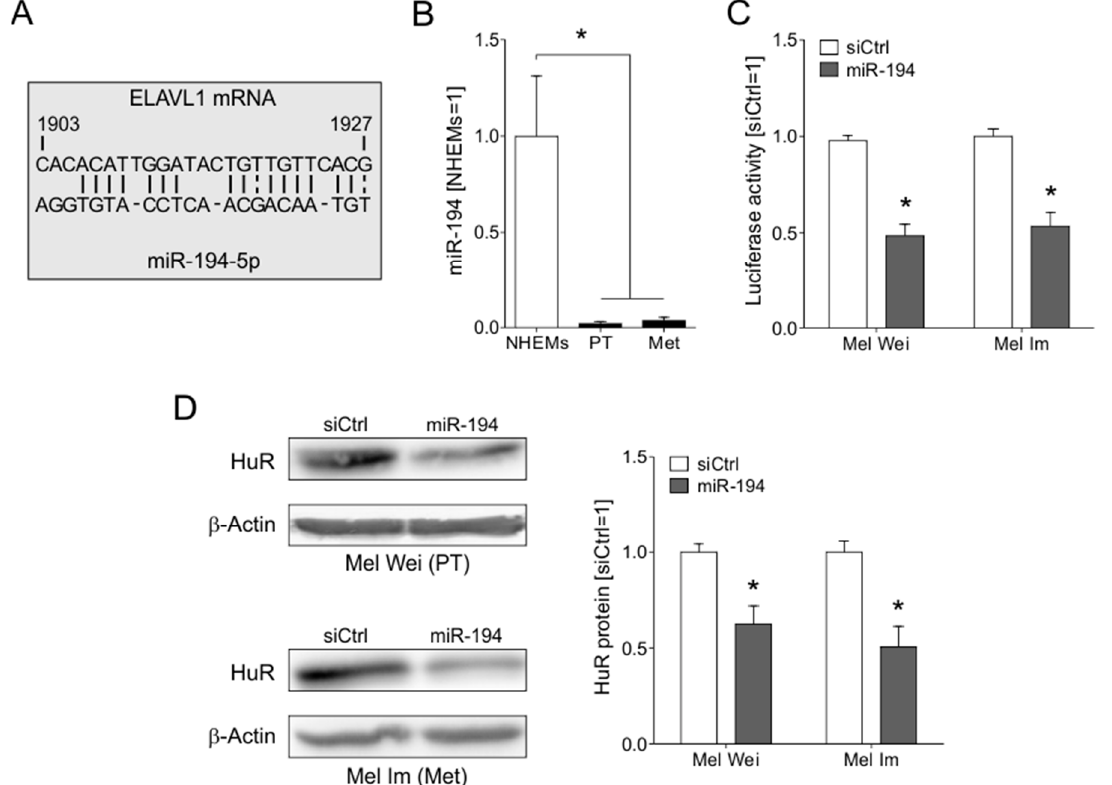
Figure 2. Regulation of HuR ( ELAVL1 ) expression by miR-194-5p. ( A ) MiR-194-5p binding site in the 3 ′ UTR of ELAVL1 mRNA. ( B ) MiR-194-5p expression levels in primary and metastatic melanoma cell lines compared to NHEMs. ( C ) Luciferase HuR 3 ′ UTR-reporter activity in siCtrl and miR-194-5p-mimic transfected melanoma cells. Activity in siCtrl transfected cells is set 1. ( D ) Densitometric quantification ( right ) and exemplary image ( left ) of Western blot analysis of HuR protein levels in siCtrl and miR-194-5p-mimic transfected melanoma cells. HuR protein level in siCtrl transfected cells is set 1. *A p -value of <0.05 was considered statistically significant. The uncropped blots and molecular weight markers of Figure 2D are shown in Figure S6.